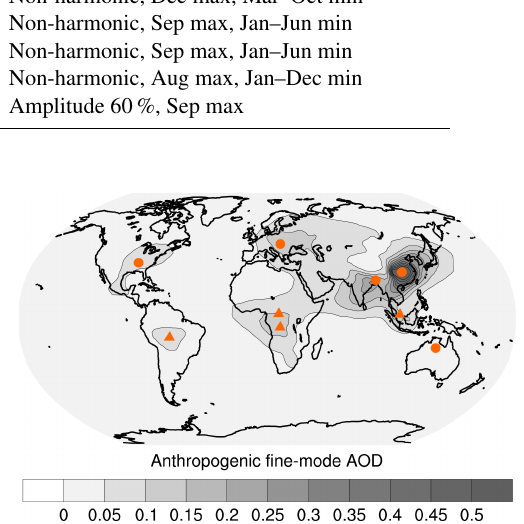
Figure 1. Global distribution of annually averaged anthropogenic aerosol optical depth τ a at 550nm. Also indicated are the locations of MACv2-SP plume centers. Industrial and biomass plumes are distinguished by the choice of symbol: circles for industrial plumes and triangles for biomass